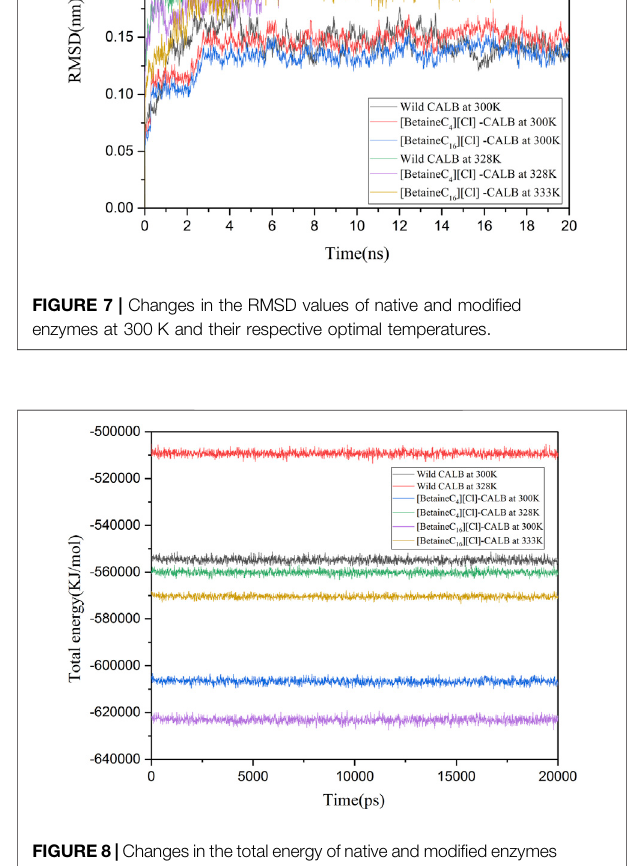
Frontiers in Bioengineering and Biotechnology |